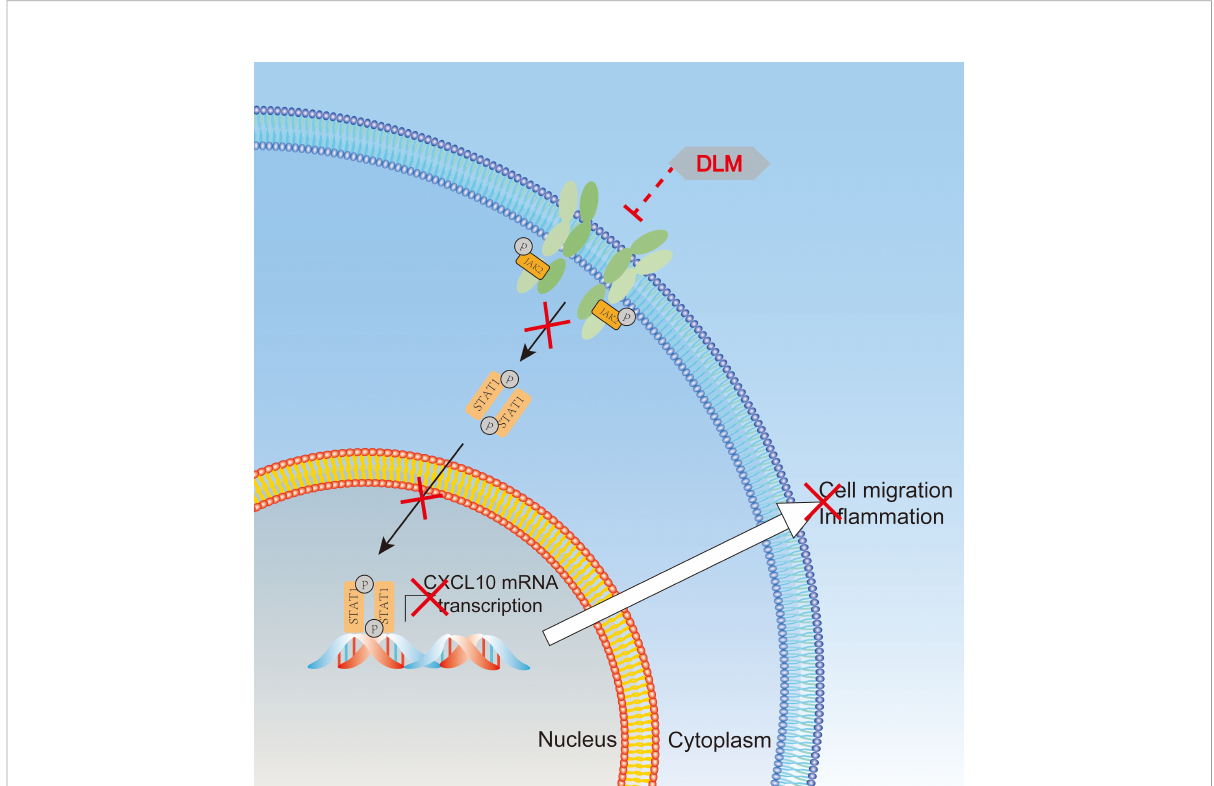
FIGURE 6 Schematic representation of putative interaction of DLM with JAK2/STAT1 signaling pathways. Schema illustrates the mechanism that DLM inhibits cell migration by suppressing the JAK2/STAT1 signaling pathway. DLM inhibited the phosphorylation (Tyr1007) and activation of JAK2 and then further inhibited the phosphorylation (Ser727) and activation of STAT1. These further induced the decrease of the downstream genes of STAT1, such as CXCL10, which participated in in fl ammation by promoting cell migration and ultimately resulted in the progression of